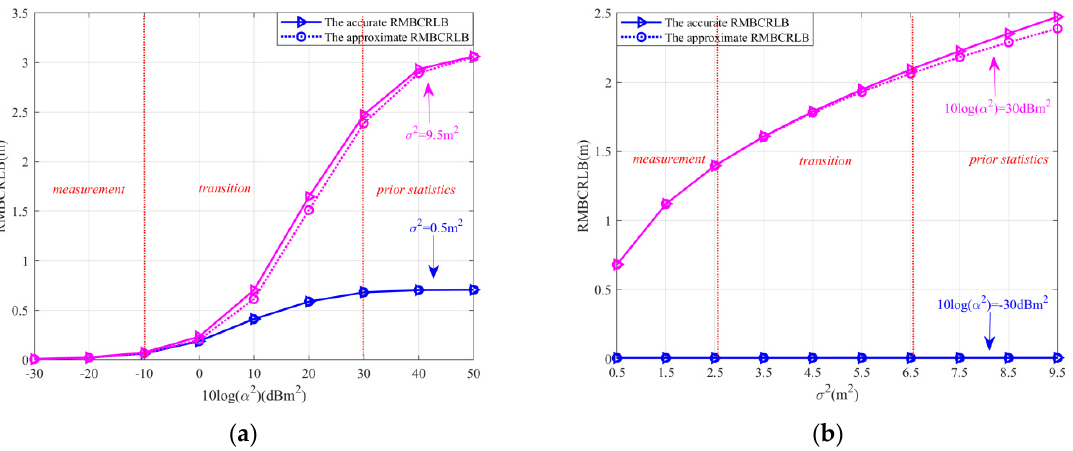
Figure 4. The RMBCRLB for configuration calibration versus 10log( α 2 ) and σ 2 in the case of inter- nal calibration. ( a ) The RMBCRLB versus 10log( α 2 ) under different σ 2 . ( b ). The RMBCRLB versus σ 2 under different 10log( α 2 ).